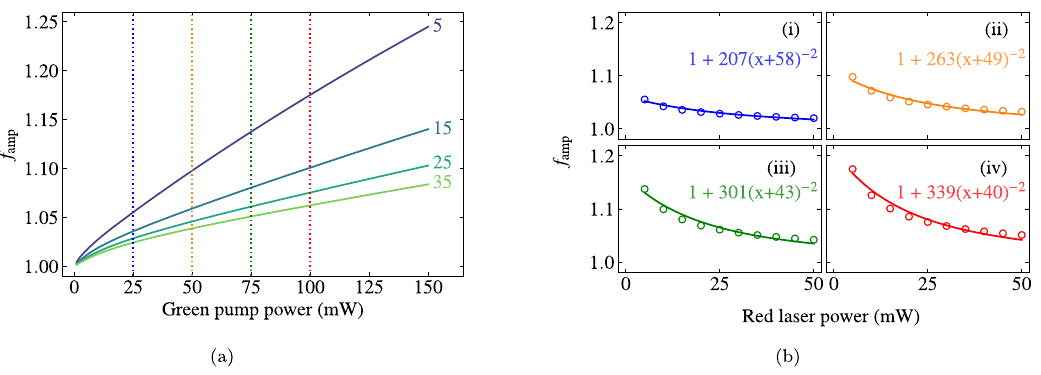
Figure 8: Change in amplification factors calculated from the theoretical model as a function of red laser power. The red laser power in mWisannotatedforeachcureintheirrespectivecolours.(b)Theamplificationfactorsinthedottedlinesdrawnin(a)asafunctionofredlaser power. The blue, orange, green, and red circles in (i), (ii), (iii), and (iv) are the ampli fi cation factors corresponding to the green pump powers25mW,50mW,75mW,and100mW,respectively,wherethedottedlinesaredrawnin(a)withrespectivecolours.Thesolidcurveswith respective colours are the fi t functions annotated in each fi